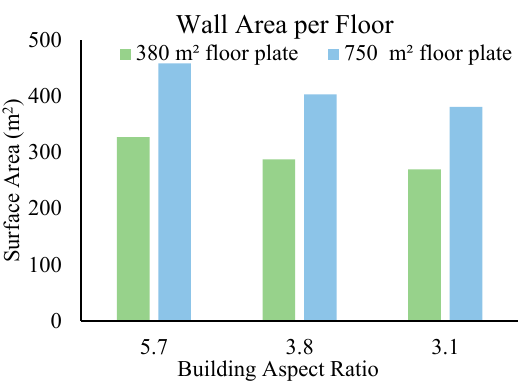
Figure 4. Wall surface area per floor for various building aspect ratios with a rectangular plan.